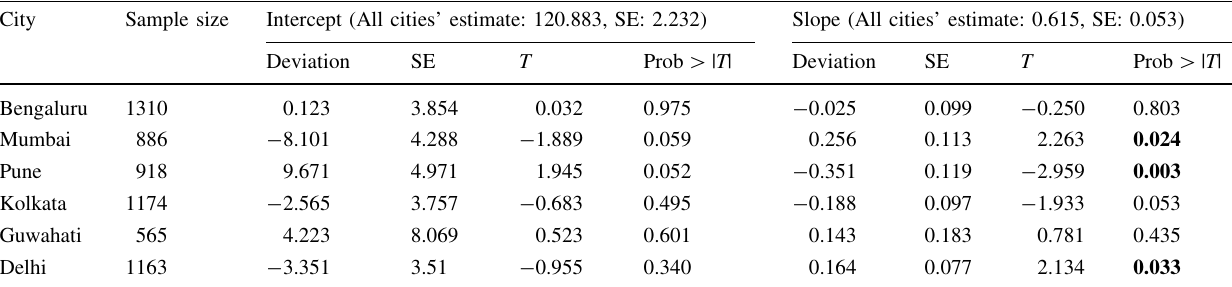
Table 2 Statistical comparison of C versus v relationship for vehicles from different cities City Sample size Intercept (All cities’ estimate: 120.883, SE: 2.232) Slope (All cities’ estimate: 0.615, SE: 0.053)